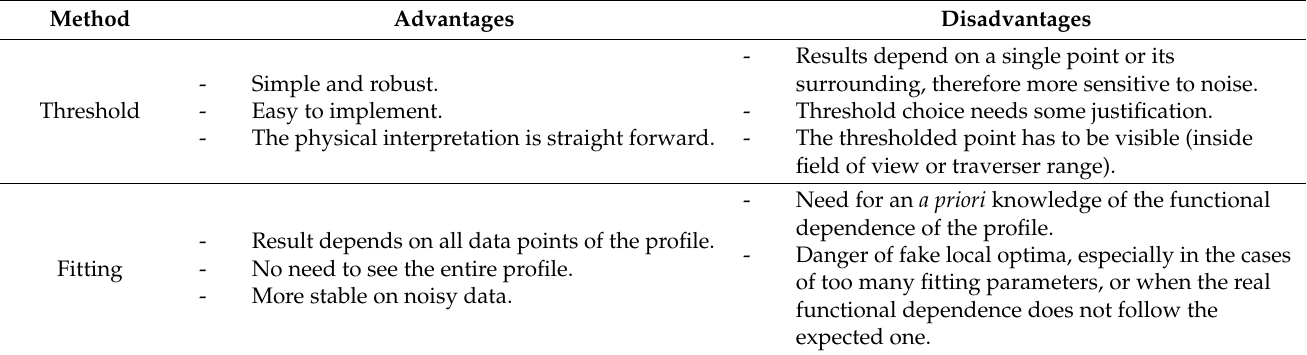
Table 1. The possible mathematical methods of extracting parameters of some data profile.